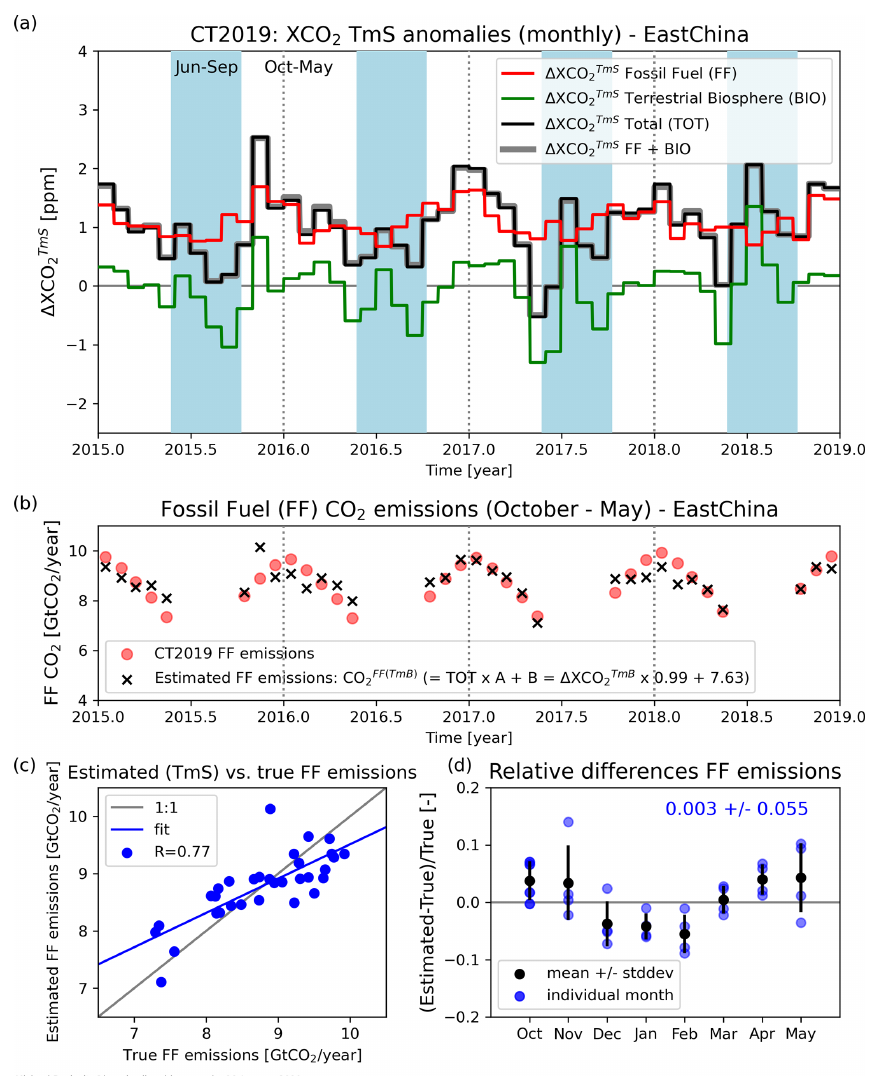
Figure A1. The same as Fig. 2 but using the target minus surrounding (TmS)